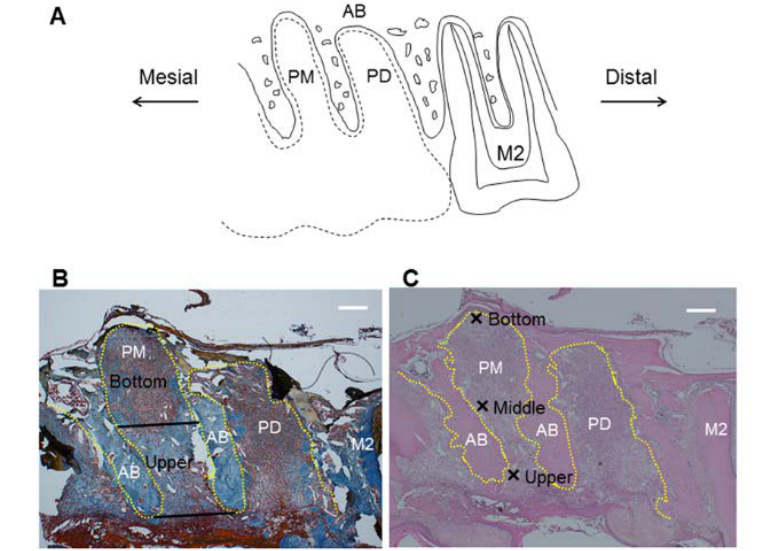
Figure 1. Measurement regions for histological analysis in the socket after tooth extraction. Sagittal plane of region of interest is shown in ( A )—Black dotted line represents extracted maxillary first molar. Regions to evaluate collagen density or FGF-2 expression are shown in ( B )—Black straight lines of the alveolar socket represent border of upper area and bottom area. Regions for counting number of polymorphonuclear leukocytes are shown in ( C )— Crosses represent upper, middle and bottom parts. Scale bar = 400 μm. Yellow dotted line: outline of alveolar socket. AB: alveolar bone; PM: alveolar socket at palatal mesial root of maxillary first molar; PD: alveolar socket at palatal distal root of maxillary first molar; M2: maxillary second